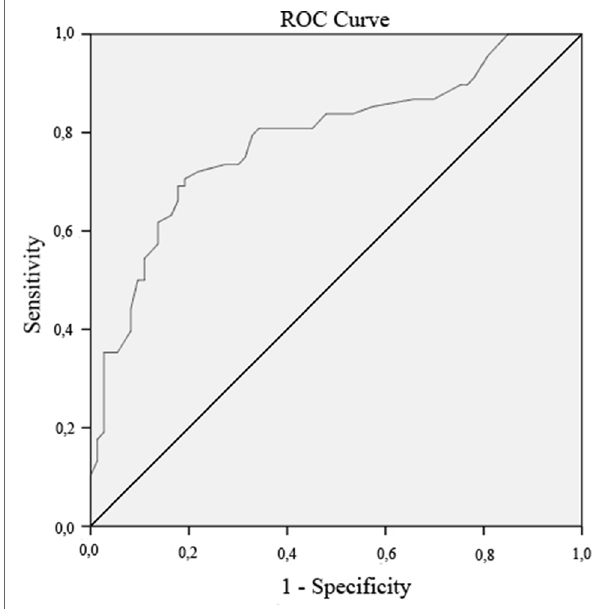
FIGURE 1 | Receiver operating characteristic (ROC) curve. The ROC curve compares the clinical population with the healthy controls in regards to the German Impact of Future Events Scale-Short (IFES-S) score, and significantly discriminates between those two